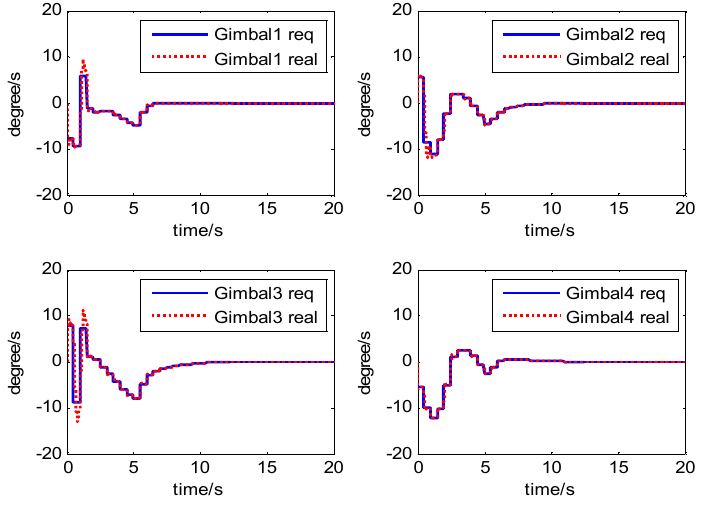
Figure 10. The gimbal rates of magnetically suspended SGCMGs.